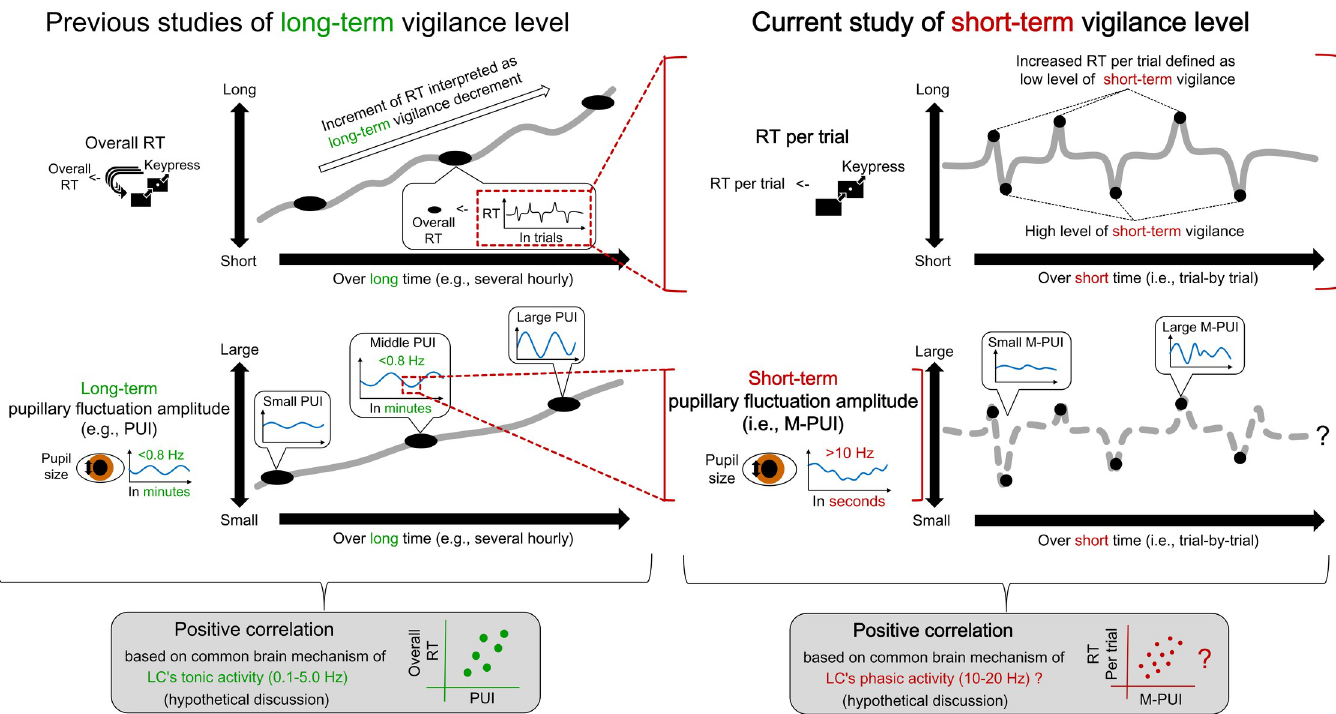
Fig 1. A conceptual summary of the current study. Previous studies, which correspond to the left panel, have confirmed the positive correlation between overall RTs in each vigilance task session (e.g., the numbers of long RTs in each PVT session) and long-term pupillary fluctuations amplitudes measured over several minutes immediately before each PVT session (e.g., PUIs below 0.8 Hz), which were acquired every several hours. The long-term increase in the overall RT is interpreted as a decrement in long-term vigilance. The underlying mechanism of this relationship could be ANS-related tonic activity of the LC from 0.1 to 5.0 Hz. On the other hand, the current study, which corresponds to the right panel, examined the positive correlation between the RTs per trial within one session of PVT and the short-term pupillary fluctuations amplitudes per trial within one session of PVT (i.e., M-PUIs measured with a fine temporal resolution of 10 Hz or more immediately before the target presentations during trials). In this study, the increase in RT per trial was defined as a decrease in short-term vigilance level. The underlying mechanism of this relationship might include the phasic activity of the LC from 10 to 20 Hz.